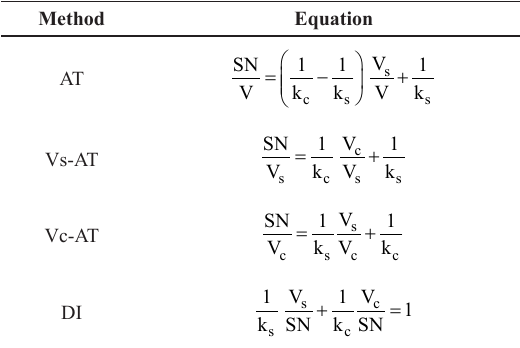
Table 1 - Data analysis